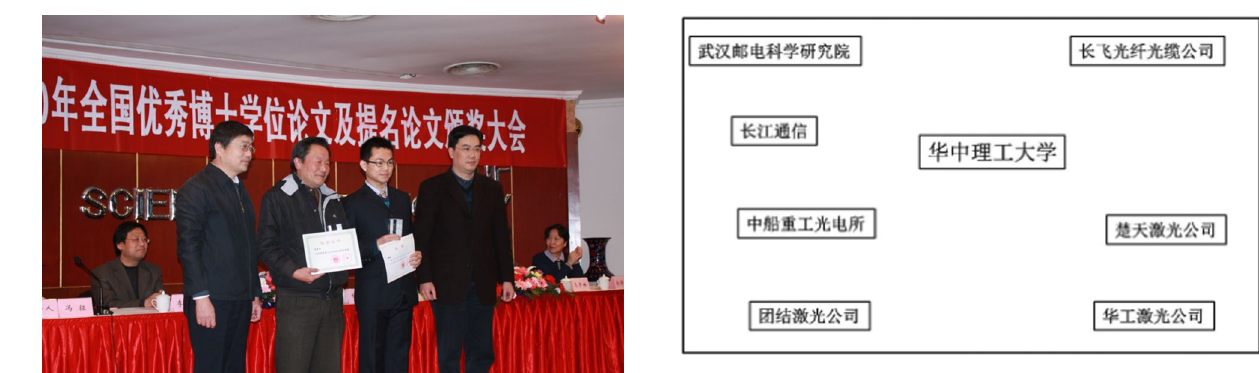
Fig. 4 Overview of some influential optoelectronic-related enterprises in Wuhan shown by Huang during the nine-day visit to Taiwan, China in